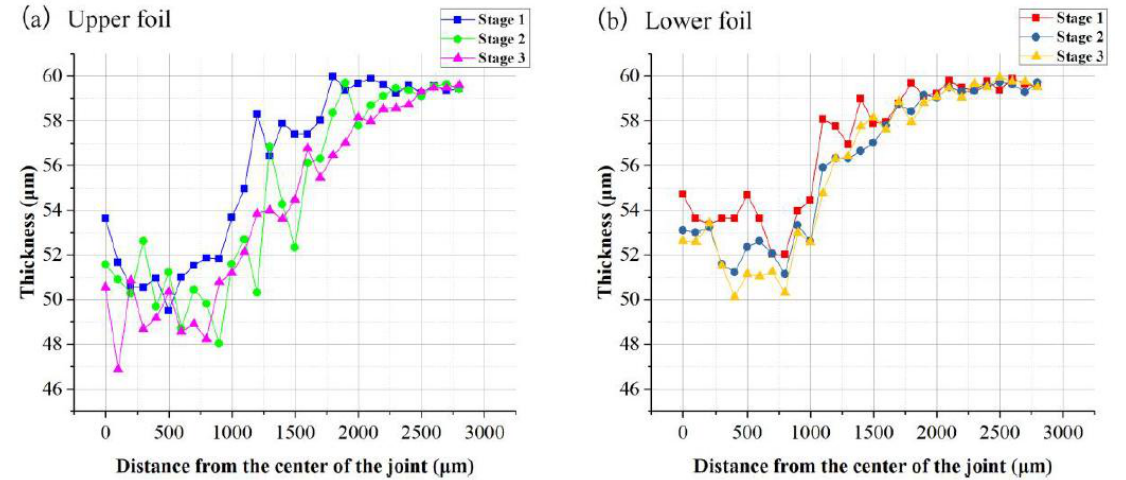
Figure 14. The A–A section thickness distribution curves in three stages: ( a ) upper foil and ( b ) lower foil.